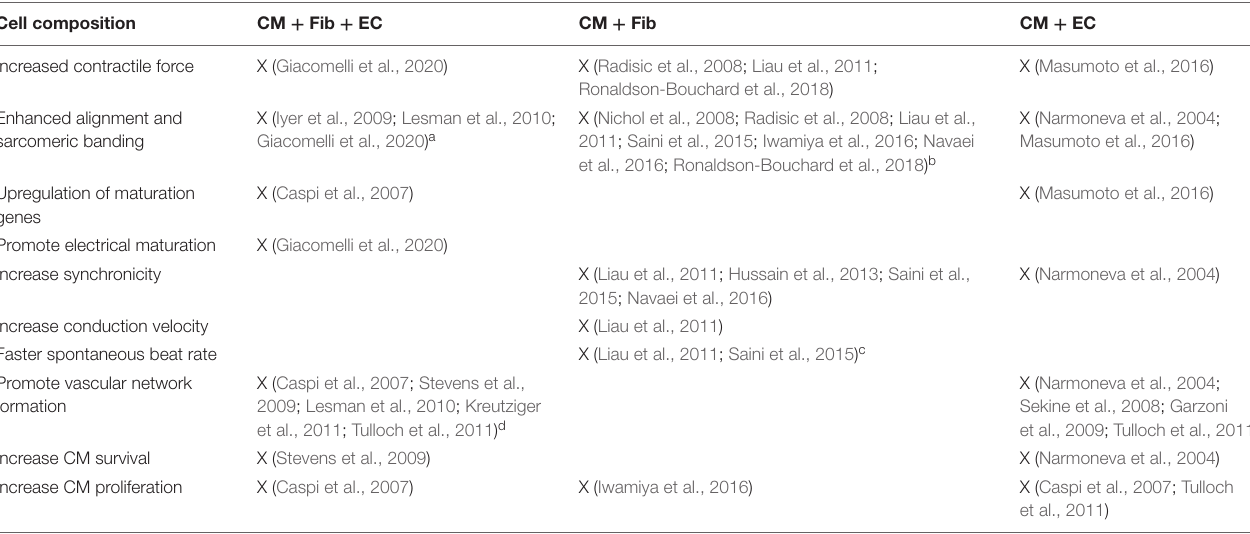
TABLE 1 | Summary of the effects of non-cardiomyocytes on engineered cardiac